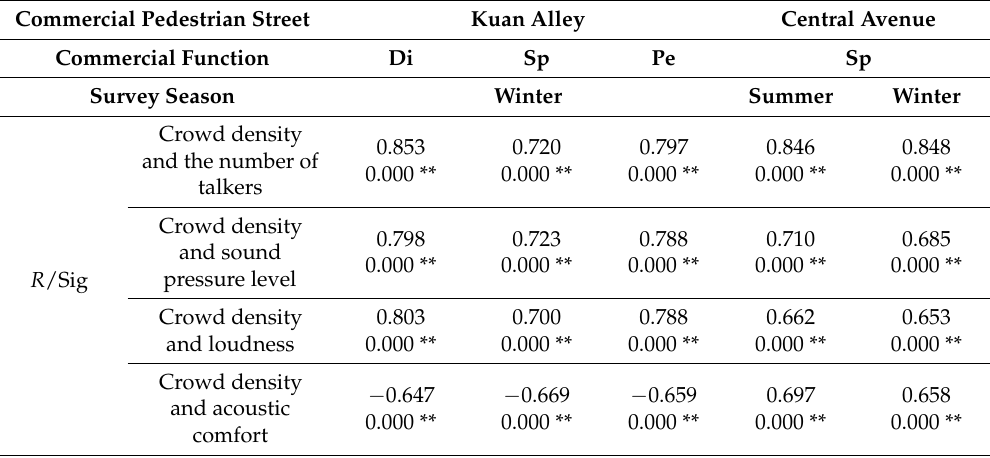
Table 4. The relationship between crowd density and the number of talkers, between crowd density and sound pressure level, and between crowd density and acoustic